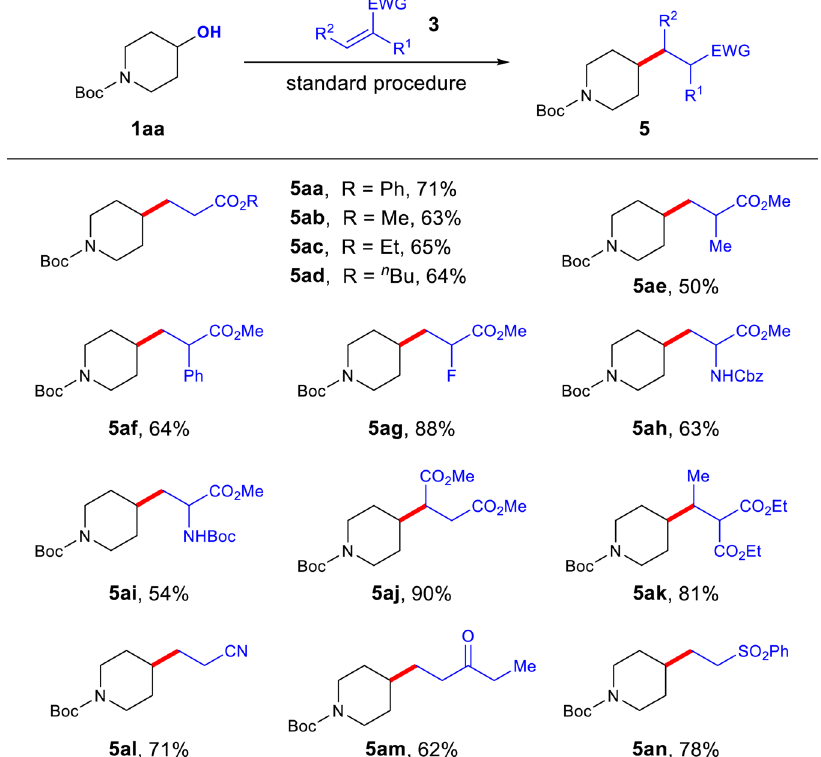
Fig. 3 Scope of alkenes. The standard procedure is as shown in Table 1. Isolated yields are reported. Cbz